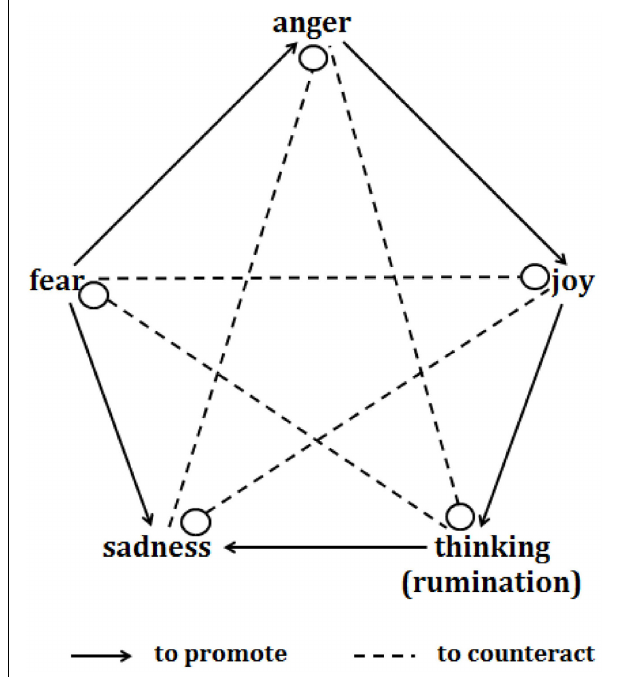
FIGURE 1 | Relationships between mutual promotion and mutual restraint and the emotions of joy, anger, sadness, thinking (which may reflect ordinary thinking and reasoning or rumination) and